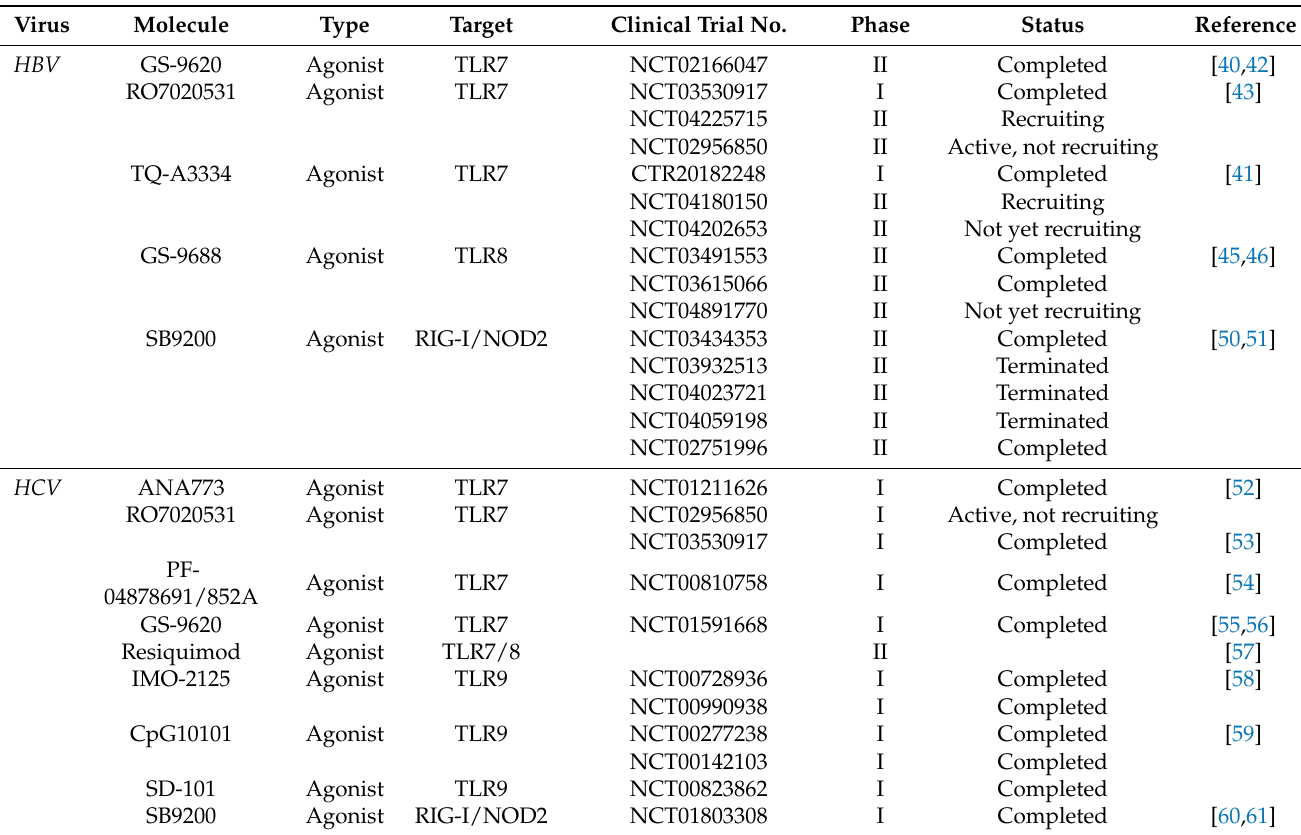
Table 1. Shown in the table is a list of PPR agonists that have been tested in clinical trials for viral infections. Indicated is the viral infection, the name of the molecule, its target and the clinical trial information such as the trial number, the phase it has reached and the current status. HBV—hepatitis B virus; HCV—hepatitis C virus; HIV—human immunodeficiency virus; HPV—human papillomavirus; HSV—herpes simplex virus; SARS-CoV-2—severe acute respiratory syndrome coronavirus 2. Virus